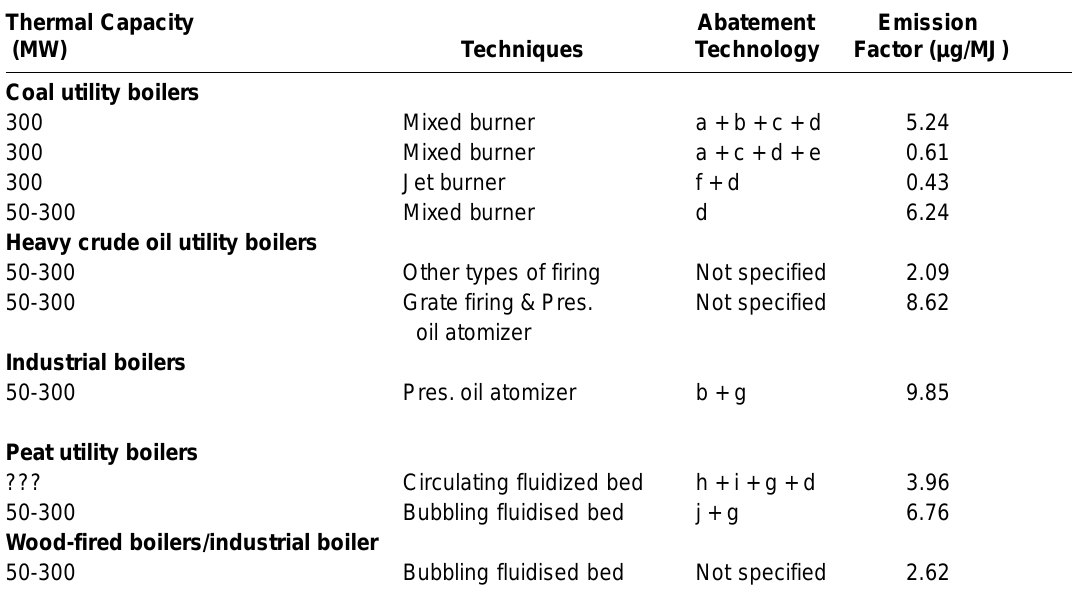
Average Emission Factor (µg/MJ) for Arsenic from Combustion of Fossil Fuels as per the Database of the Finnish Environmental